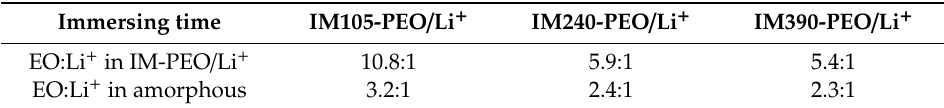
Figure 1. Schematic of the immersion process and Li + distribution. The orange lines and red lines denote the PEO amorphous chain segments and chain ends, respectively. The black lines denote the crystalline PEO chains, and the green balls denote the Li + ions. Table 1. The ratio of EO: Li + in the samples with three different immersion (IM) times. PEO, polyethylene oxide. Table 1. The ratio of EO: Li + in the samples with three di ff erent immersion (IM) times. PEO, polyethylene oxide.